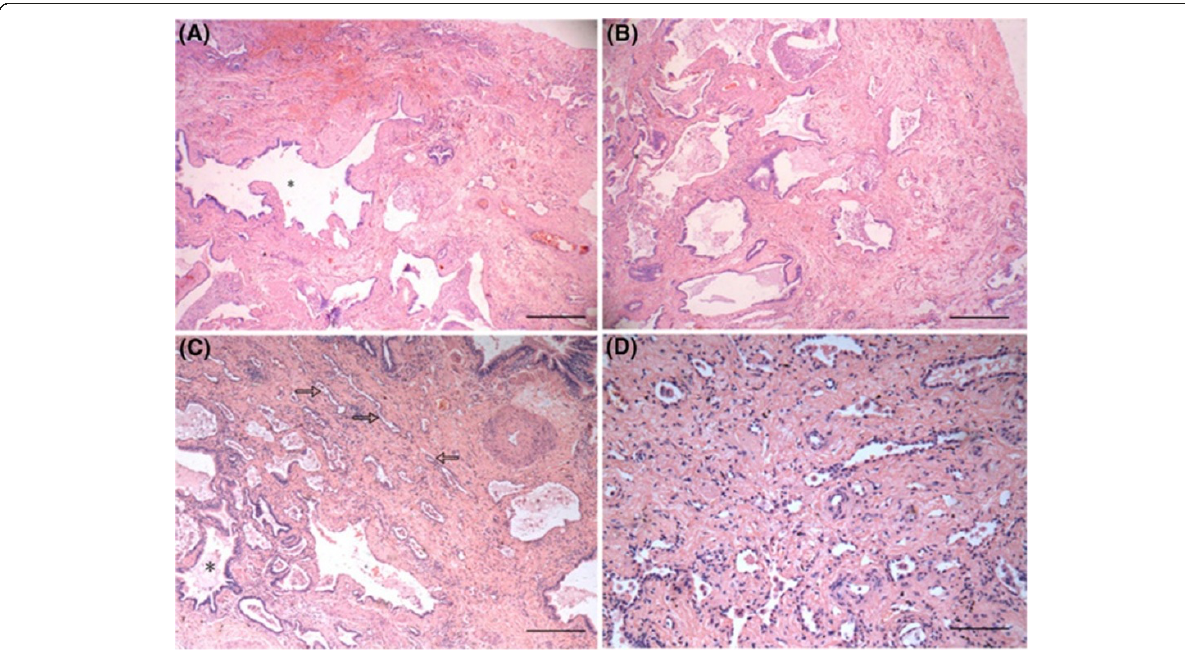
Figure 4 Microscopic features of the patient's lung middle and low lobes. Under low power microscope, the structure of middle ( A , B ) and lower lobes ( C ) were basically same (from where labeled “ c and d ” in Figure 2), The proliferative fibrous tissue thickened alveolar wall, resulted in the narrowness of alveolar space, even obstruction(hollow arrow). Some regions had fibrosis and consolidation, alveolar structural remodeling and many cystic fibrous gas cavity (*). NSIP-F or UIP was not easy to distinguish. In lower lobe, it is still visible the diffuse fiber hyperblastosis and residual alveolar structure in fibrotic tissues,indicating NSIP-F ( D ). ( H&E stain, Magnification:HE×40).